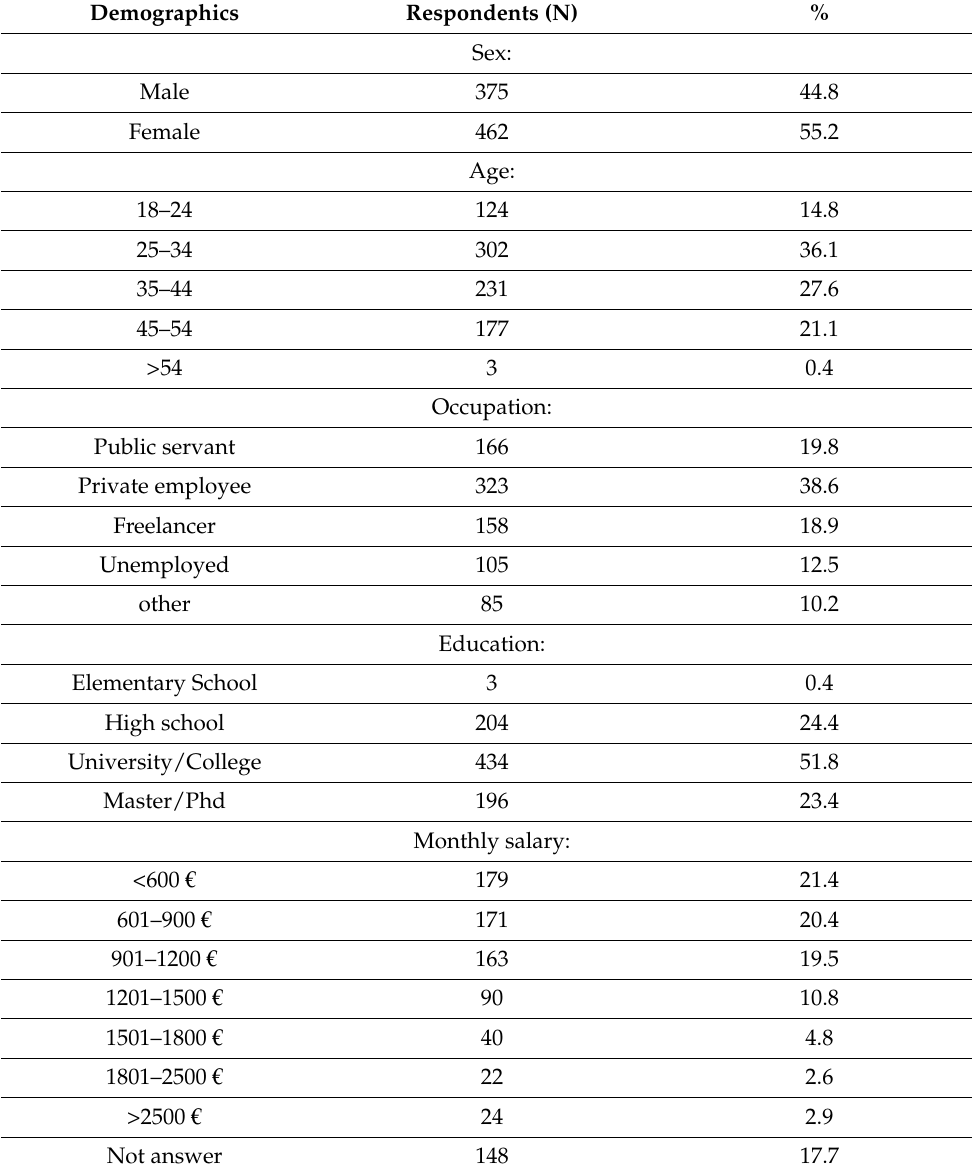
Table 2. Demographic